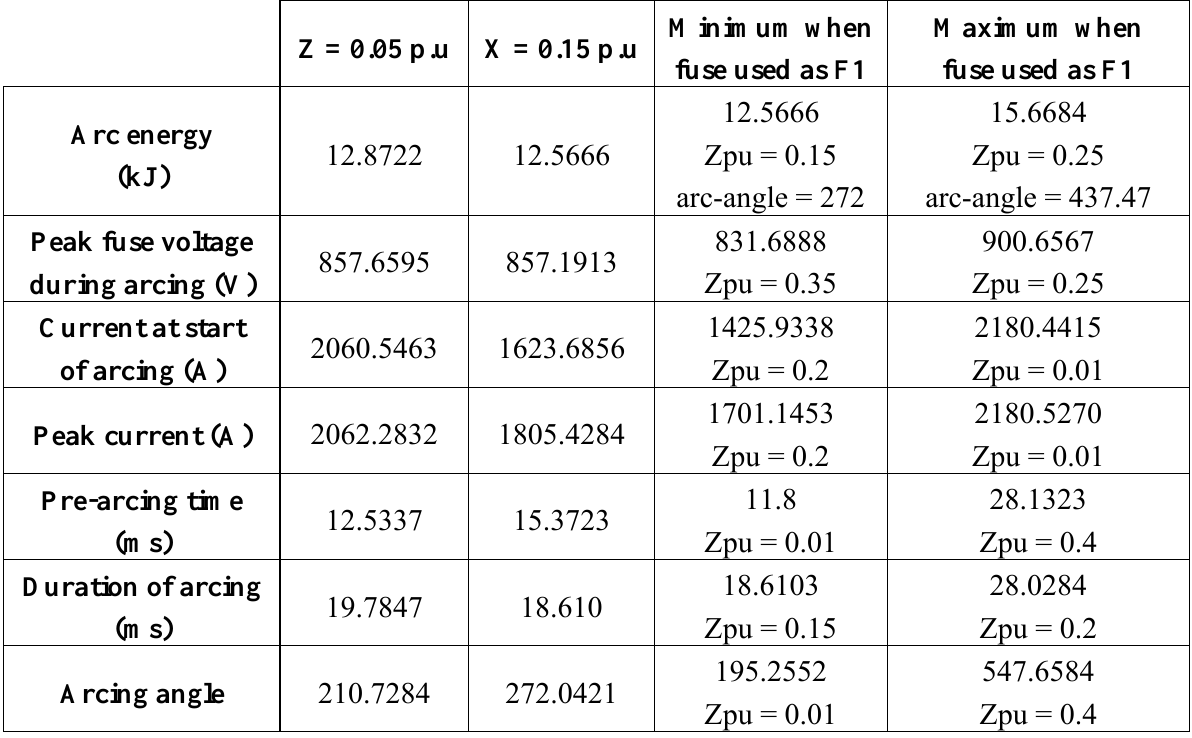
at start of arcing, peak prospective current, pre-arcing time, arcing duration, arc-angle and the system